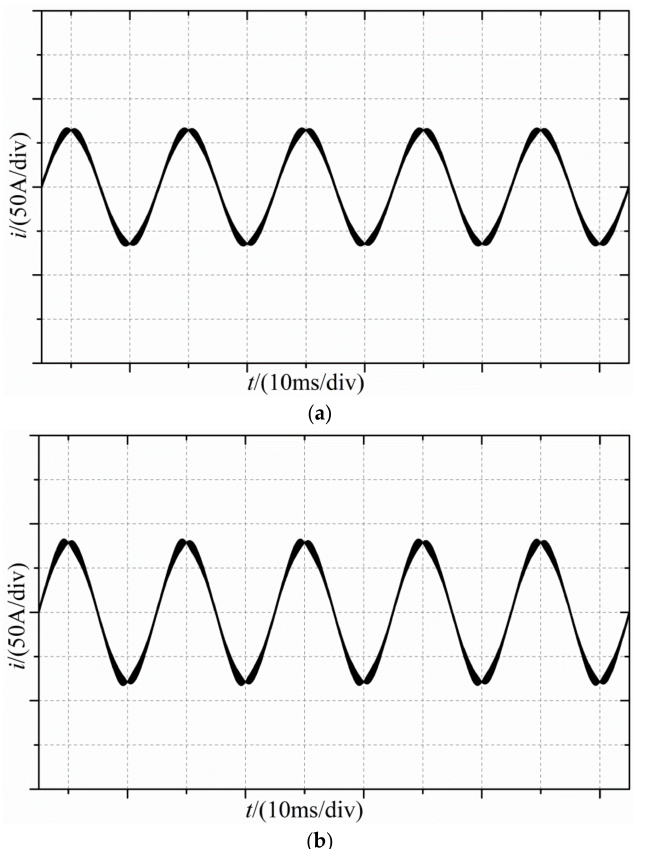
Figure 8. Simulation results with different magnitudes of output current reference when the loop gain compensation unit is introduced: ( a ) magnitude of output current reference is 60 A; ( b ) magnitude of output current reference is 70